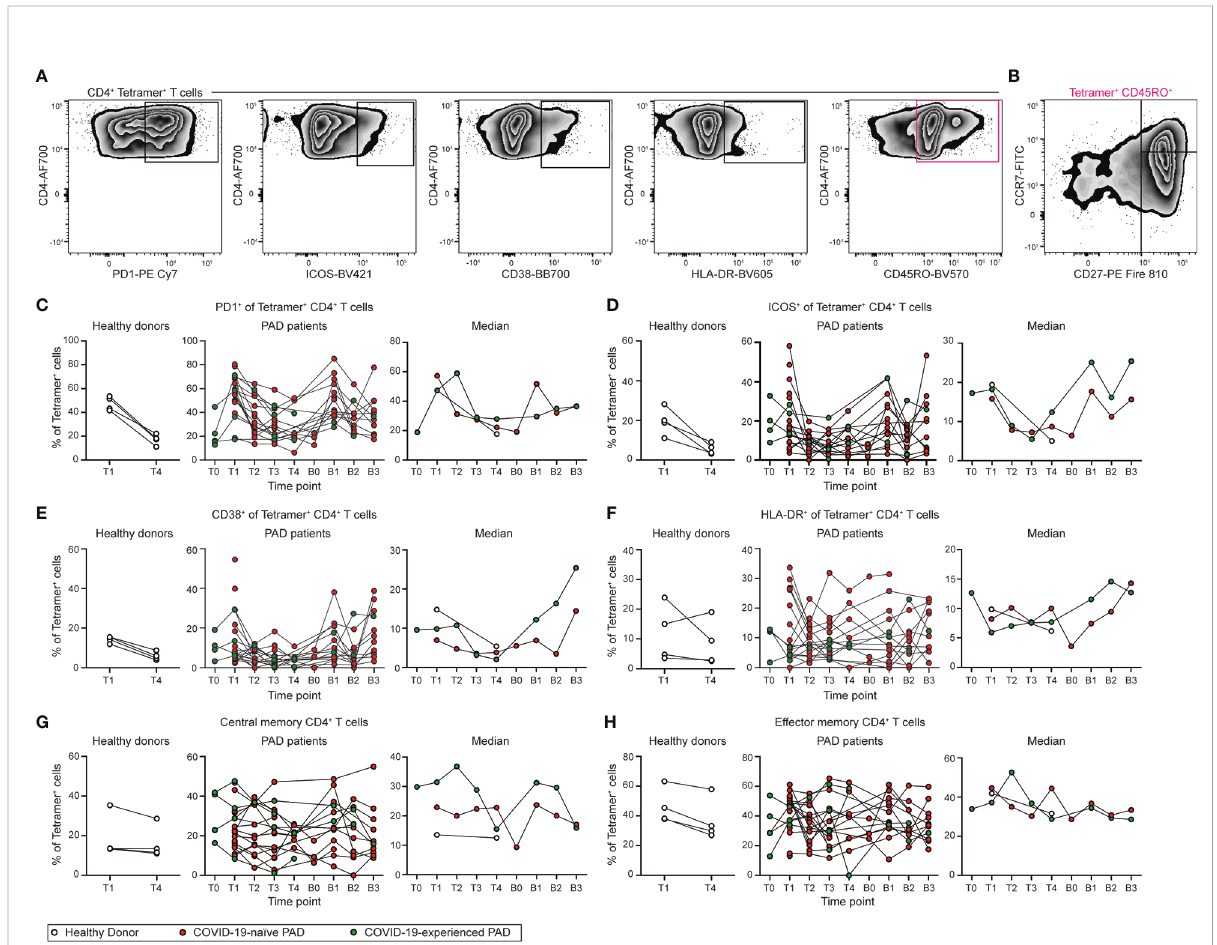
FIGURE 7 Phenotype of SARS-CoV-2-speci fi c CD4 + T cell response following vaccination in PAD patients. (A) Representative fl ow cytometry plots of the expression of PD1, ICOS, CD38, HLA-DR, and CD45RO on Tetramer + CD4 + (Live CD3 + CD19 - CD4 + CD8 - S 167-180+ or S 816-830+ ) T cells. (B) Representative fl ow cytometry plots of the expression of CD27 and CCR7 on CD45RO + Tetramer + CD4 + T cells. Percentage of Tetramer + CD4 + T cells that are (C) PD1 + , (D) ICOS + , (E) CD38 + , (F) HLA-DR+, (G) central memory (CD45RO + CD27 + CCR7 + ), or (H) effector memory (CD45RO + CD27 + CCR7 - ) in healthy donors (left, white), COVID-19-naïve PAD (middle, red), and COVID-19-experienced PAD (middle, green) cohorts. Median percentage of Tetramer + T cells that that comprise each population in all groups is shown on right. See also Figure